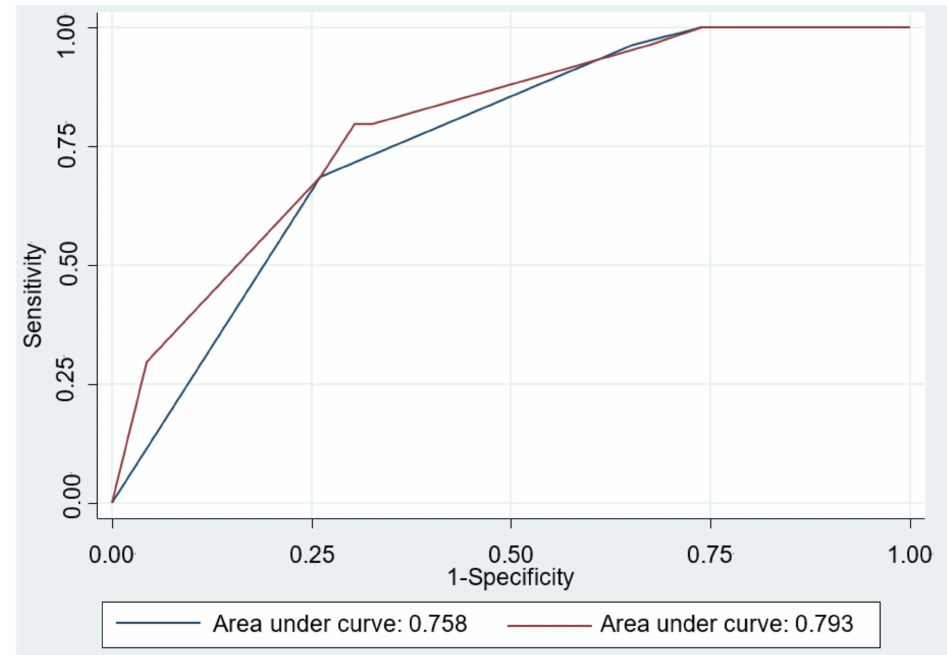
Figure 3. Area under the receiver operating characteristic (AUROC) curve for the predictive model differentiating achalasia from refractory gastroesophageal reflux disease. The AUROC curve was 0.758 in Model 1 (blue line), including Eckardt score ≥ 4, and normal esophagogastric junction morphology or esophageal food retention by esophagogastroduodenoscopy. The AUROC curve was 0.793 after including the histopathologic feature (coexistence of petechiae formation and hypertrophy of the muscularis mucosae) in Model 2 (red line). Comparison between two prediction models showed significant difference ( p =